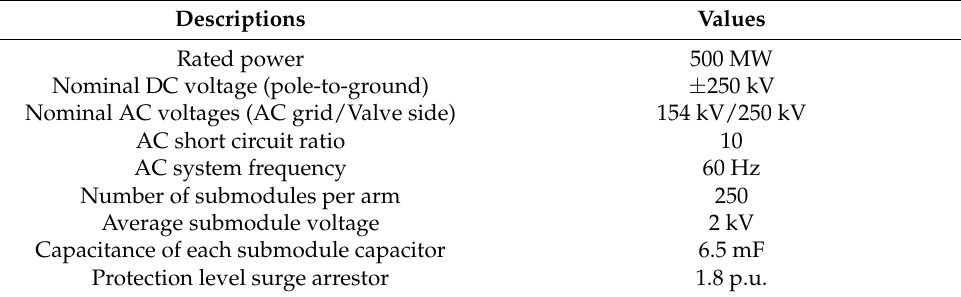
Figure 8. Schematic diagram of the MMC-HVDC system. Table 5. Specifications of the MMC-HVDC system.